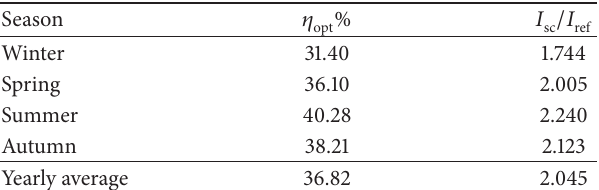
Table 2: The average values of 𝜂 mounted TLSC for one year (Riyadh,